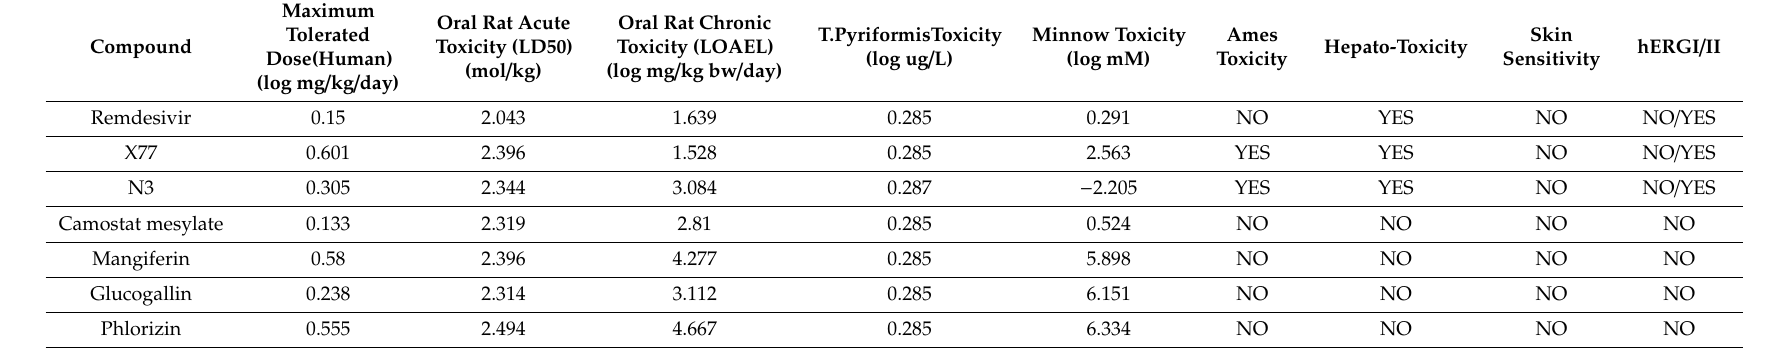
Table 3. Prediction of toxicity study of the